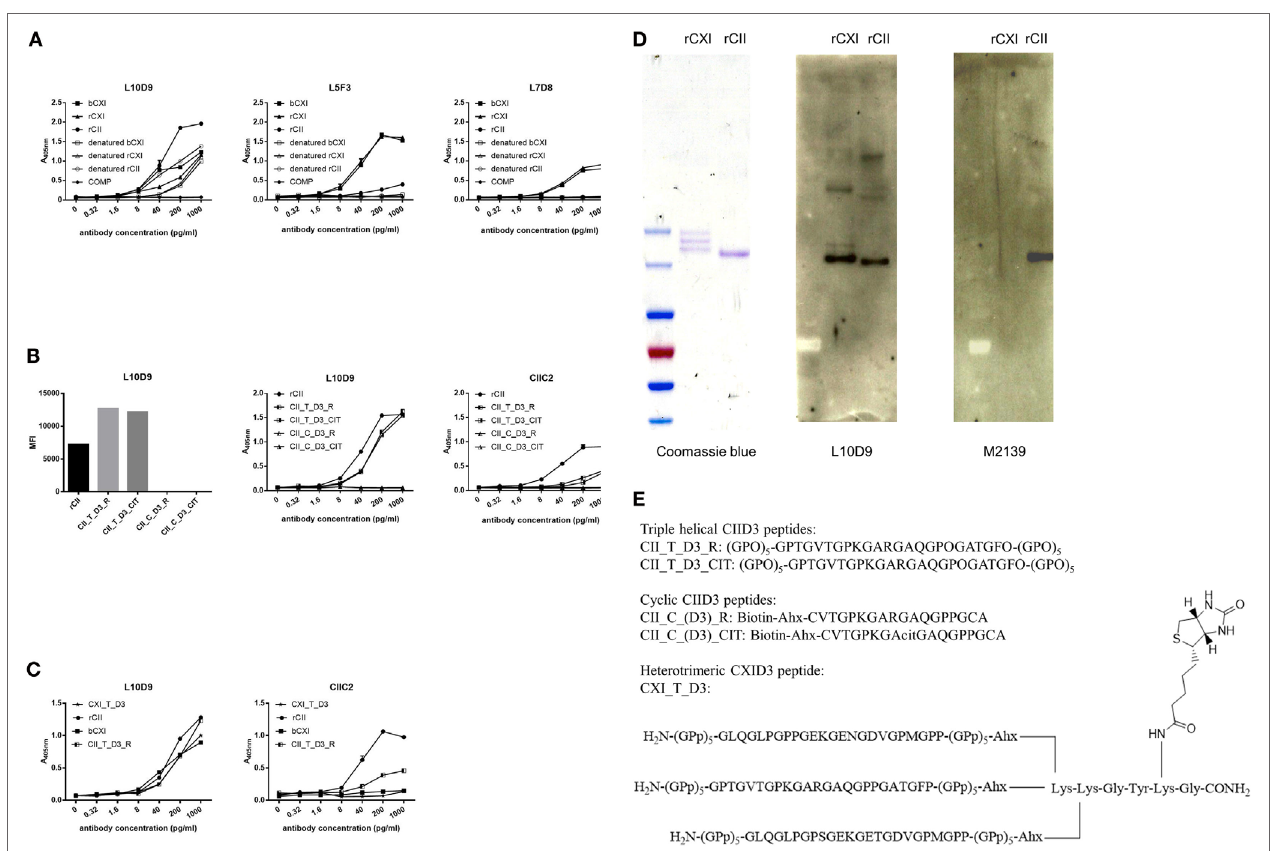
FigUre 3 | L10D9 binds to CXI, cross-react with CII due to sequence similarity. (a) Kinetics of L10D9, L5F3, and L7D8 antibody response to bCXI, rCXI, rCII, and their denatured forms. Cartilage oligo matrix protein (COMP) was served as a negative control. Bead-based multiplex immunoassays [ (B) , left panel] and enzyme- linked immunosorbent assays (ELISA) [ (B) , middle and right panel] were used for the epitope mapping of L10D9. (c) The binding of L10D9 and CIIC2 to the heterotrimeric CXI_T_D3 peptide. (D) SDS-PAGE for rCXI and rCII (left panel). Western blotting for L10D9 (middle panel) and M2139 (right panel). (e) Sequence of the peptides involved in ELISA and bead-based multiplex